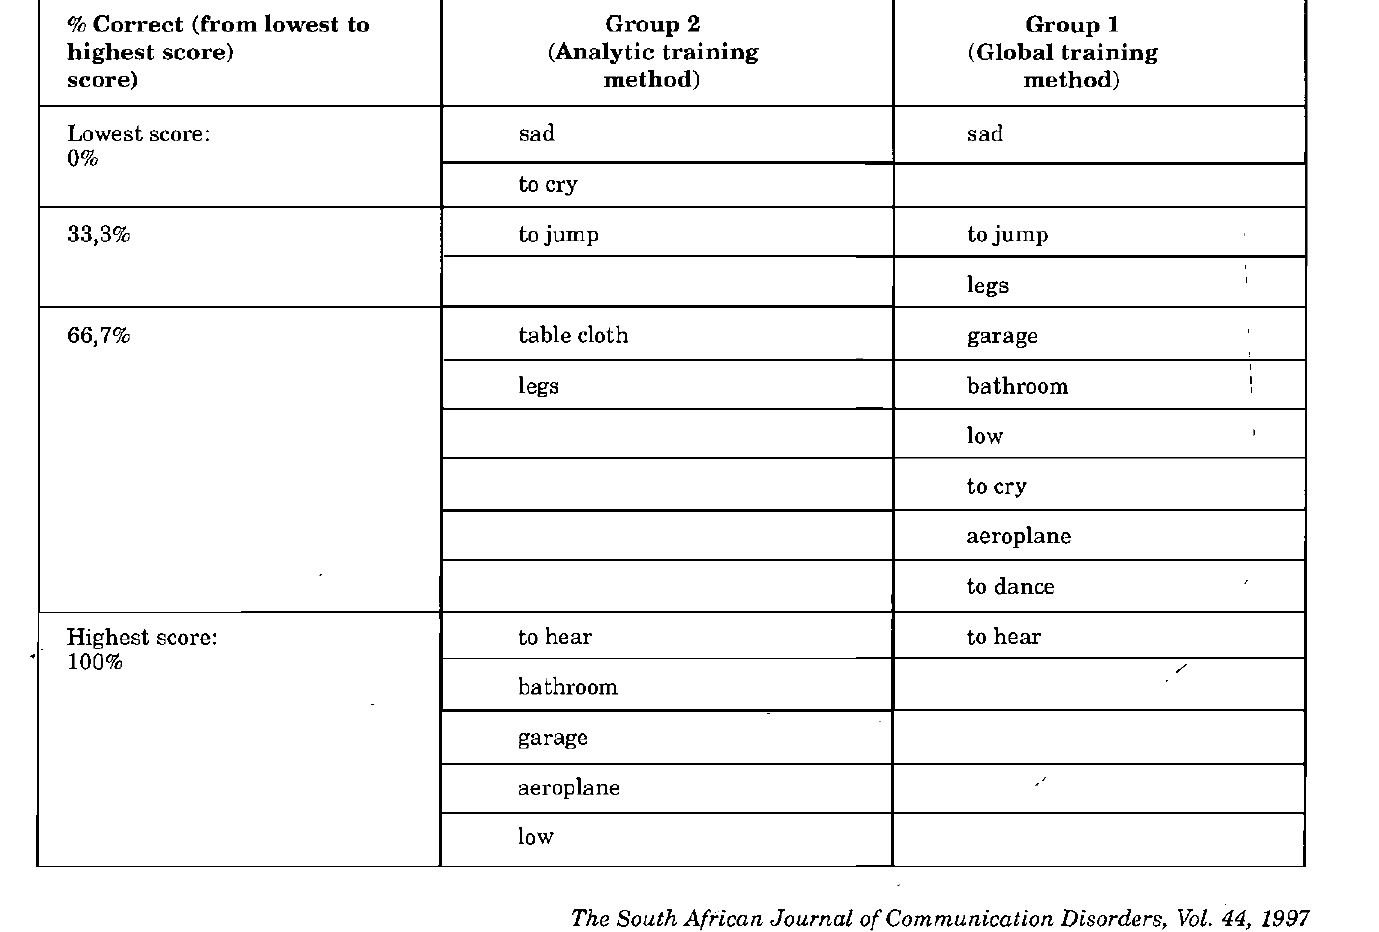
TABLE 8. An error analysis of the results obtained during the generalization procedure % Correct (from lowest